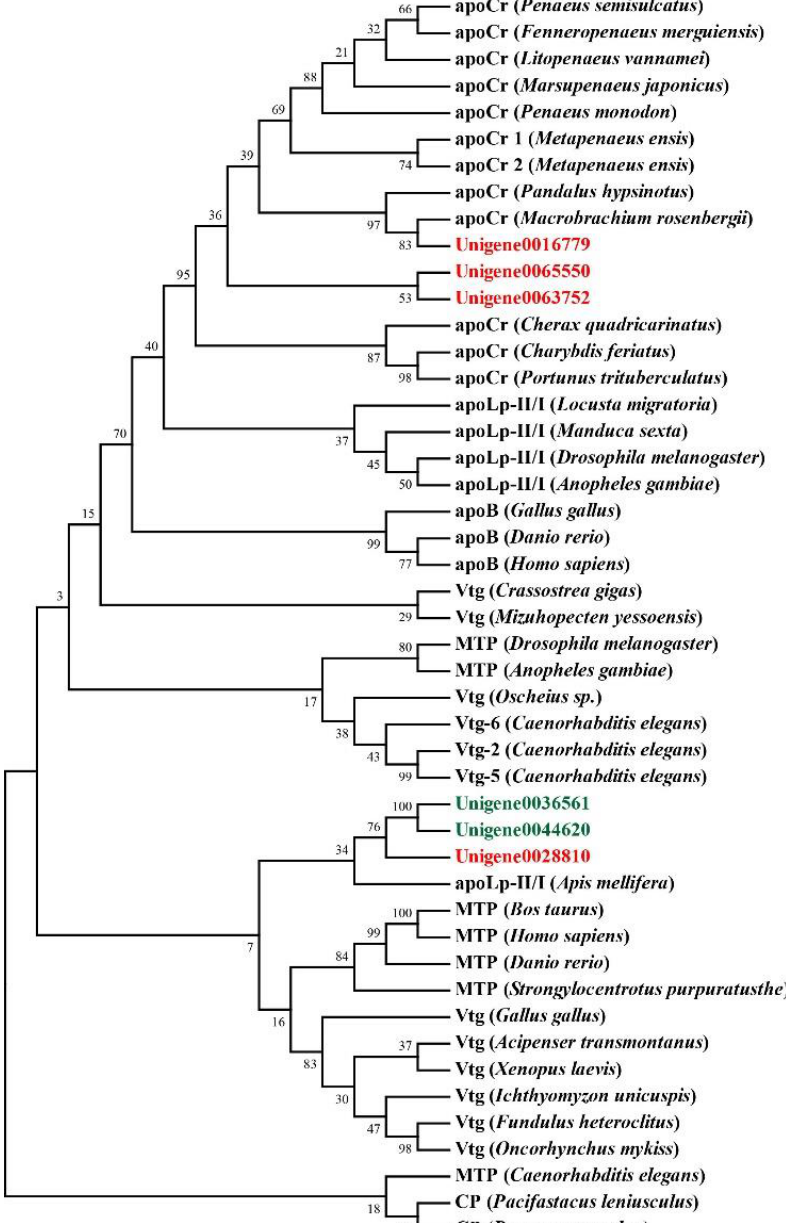
Figure 5. Evolutionary relationships of lipoproteins from E. carinicauda and other species. All DEGs with higher expression levels in the orange-red-variant prawns were marked with red font in the tree, while DEGs with lower expression levels were marked with green font. apoCr, apolipocrustacein; MTP, microsomal triglyceride transfer protein; apoB, vertebrate apolipoprotein B; Vtg, vitellogenin; apoLp-II/I, insect apolipophorin II/I precursor. Accession numbers for these sequences were indicated in Table S3. Table 5. Differentially expressed genes in Lysosome pathway.